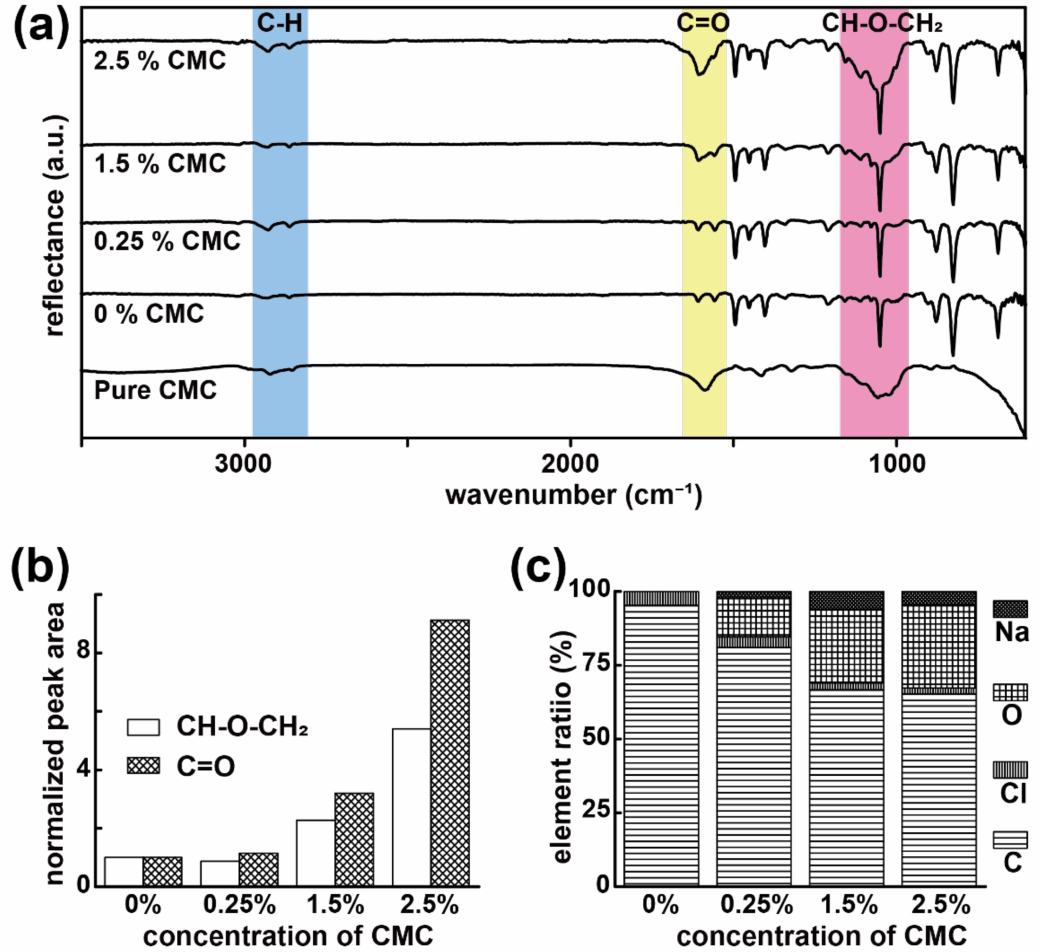
Figure 3. Regulation and encapsulation of CMC molecules. ( a ) FT-IR analysis showed regulated concentrations of CMC in the capsule products. ( b ) Quantified and normalized peak intensity of C=O and CH-O-CH 2 in panel ( a ) indicated a consistent increase according to the increased stoichiometric concentrations of CMC. ( c ) EDS elemental analysis revealed similar trends in the carbon and oxygen composition variations corresponding to the regulations of CMC